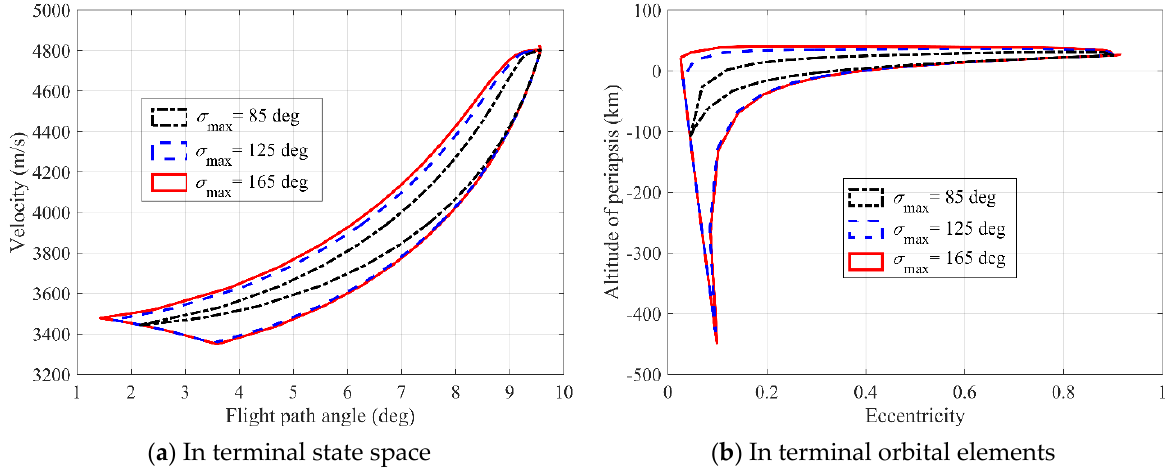
Figure 12. Aerocapture attainability sets with different upper bounds of bank angle.